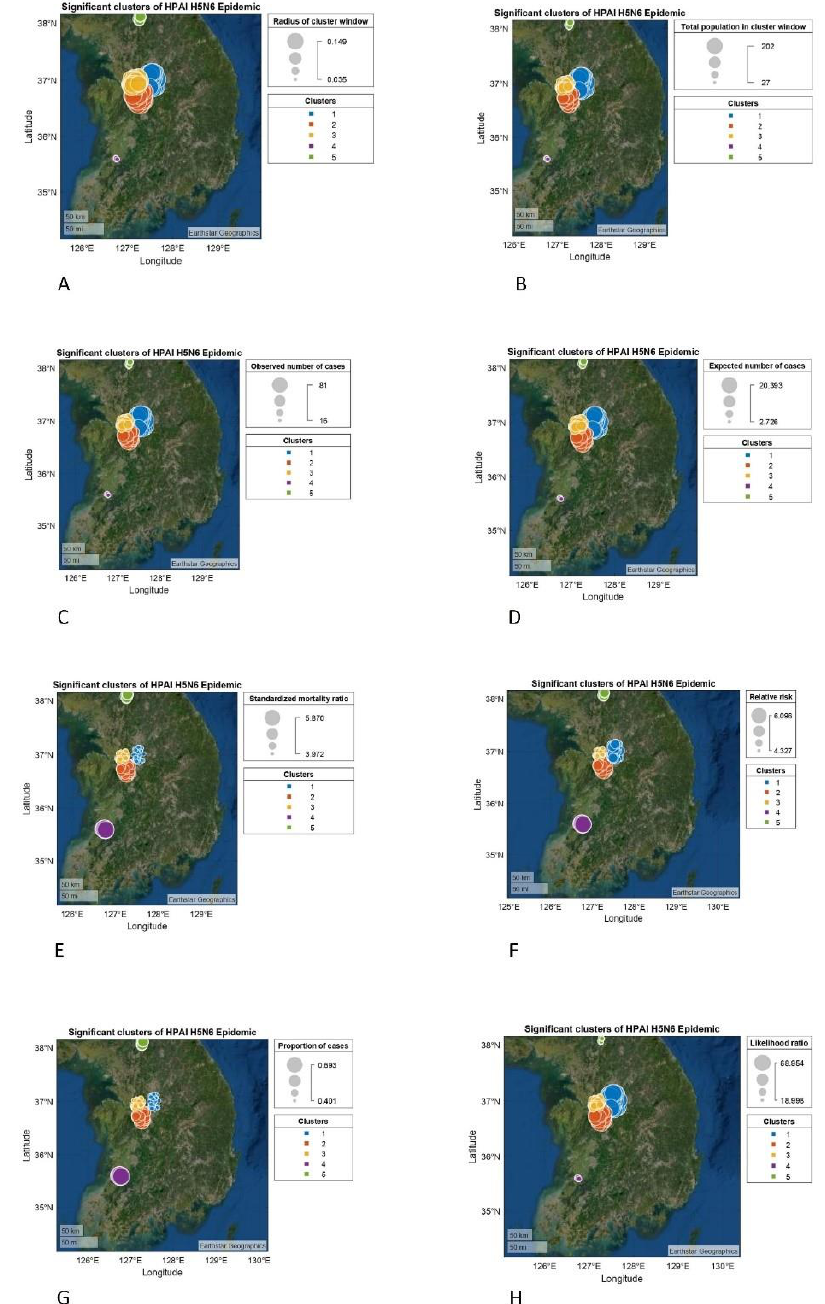
Figure 5. Spatial clusters for the highly pathogenic avian influenza H5N6 epidemic (represented by different colors) detected in the provinces of Chungcheongbuk-do, Chungcheongnam-do, Jeollabuk- do and Gyeonggi-do: ( A ) radius of cluster window showing that clusters 1, 2, and 3 were, respectively, higher than cluster 4 and 5; ( B ) total population (number of poultry farms) was higher in cluster 1 followed by clusters 2, 3, 4, and 5; ( C ) showing that the observed number of cases was highest in cluster 1, followed by clusters 2, 3, 4, and 5, respectively; ( D ) showing the expected number of cases in all clusters; ( E ) showing that the standardized mortality ratio was highest in cluster 4, followed by clusters 5, 2, 3, and 1; ( F ) showing relative risk in all significant clusters. Relative risk of cases was higher in cluster 4, followed by clusters 5, 2, 1, and 3; ( G ) showing the highest proportion of cases in cluster 4, followed by clusters 5, 2, 3 and 1; ( H ) showing that the likelihood ratio was highest in cluster 1, followed by cluster 2, and clusters 3, 4 and 5. See Table